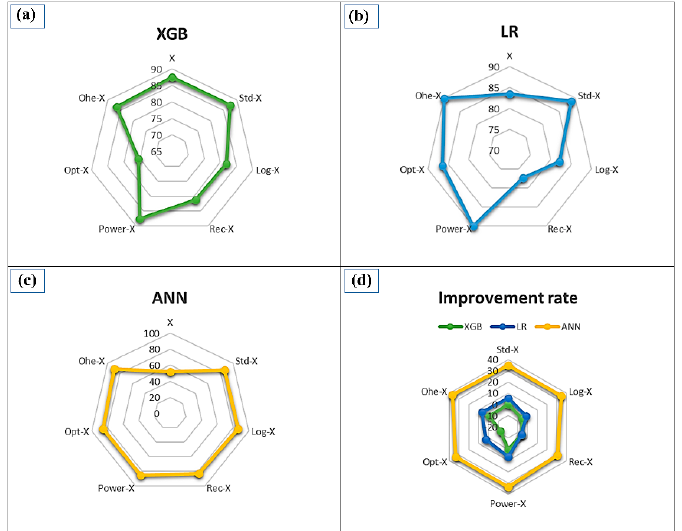
Figure 9. The quantity of the advantages acquired by various transformation models: ( a ) XGB; ( b ) LR, and ( c ) ANN. ( d ) Percentage of improvement rate from the base model (The distance from the center indicates quantity of benefit received from the transformations).